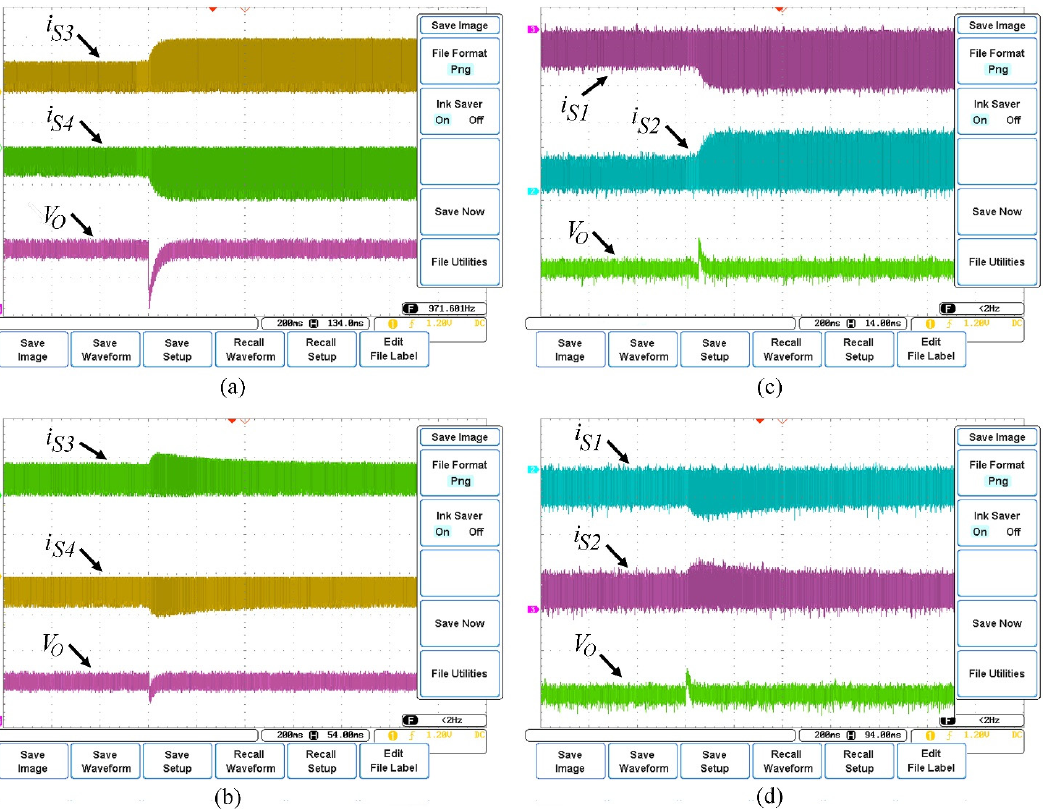
Figure 16. Experimental results for ( a ) OCF on switch S 1 in forward mode without fault-tolerant system: ( b ) OCF on switch S 1 in forward mode with proposed fault-tolerant system; ( c ) OCF on switch S 4 in reverse mode without fault-tolerant system; ( d ) OCF on switch S 4 in reverse mode with proposed fault-tolerant system. Table 2. Proposed fault diagnosis algorithm compared with other methods.